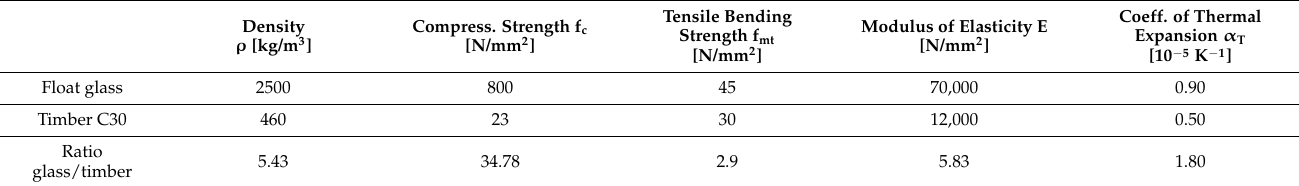
Table 1. Material properties of float glass and softwood C30